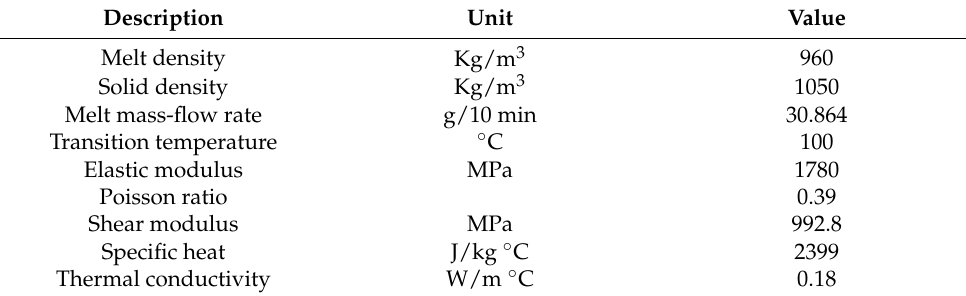
Table 1. ABS blend data table.